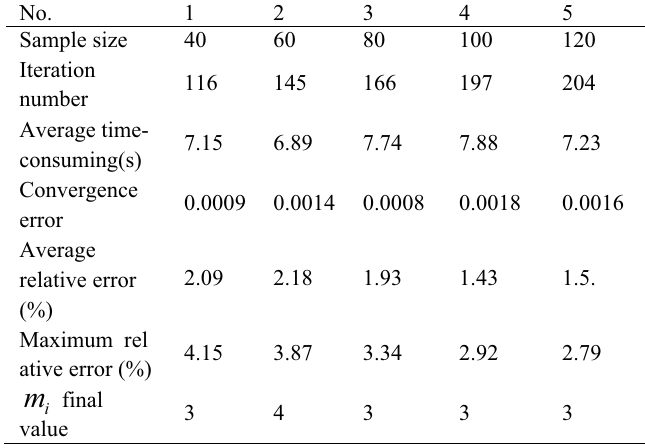
Table 3. Simulation experiment